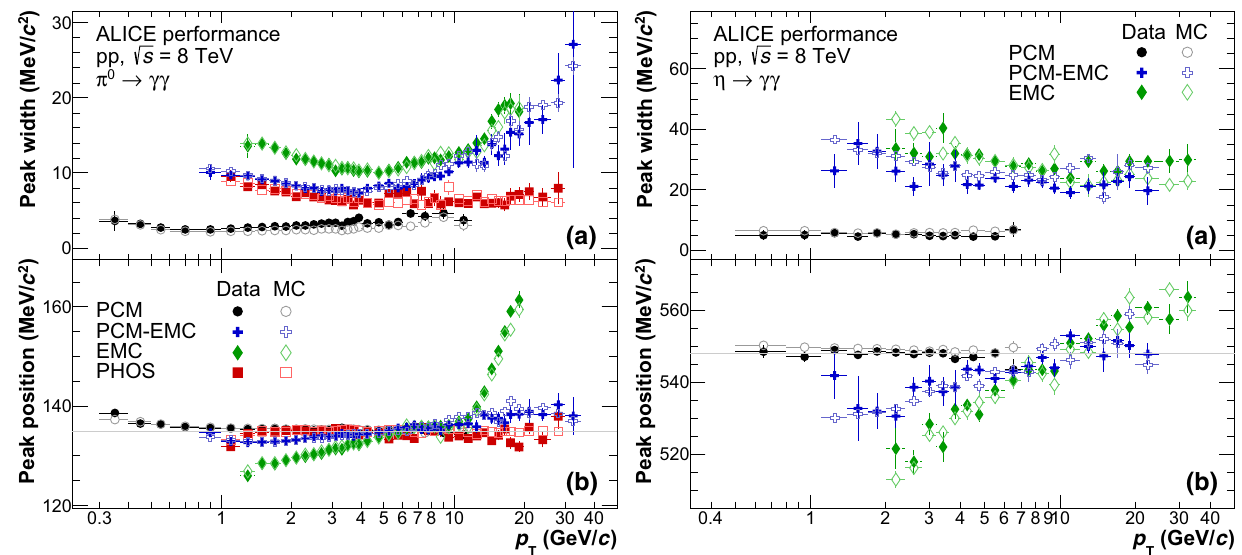
Fig. 4 The left plots show reconstructed π 0 peak positions (left- bottom) and widths (left-top) of each reconstruction method compared to MC simulations for the transverse momentum bins used in the analy-